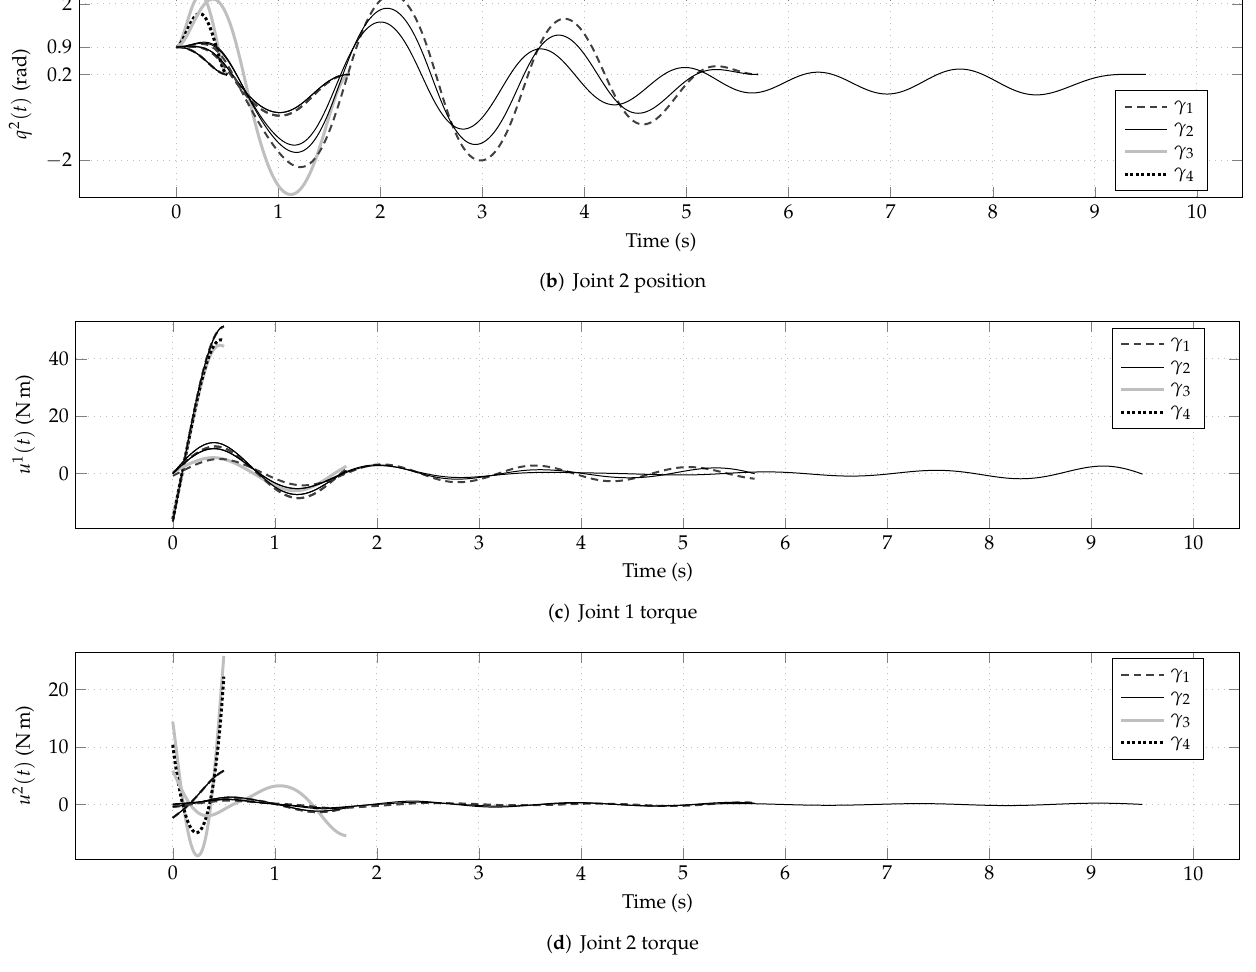
Figure 7. Numerical solution of the optimal control for a downward motion (see Step 1 of Section 6.1.3). Optimal torque and position evolution along four simulated trajectories: T = 0.5s, T = 1.7s, T = 5.7s, and T = 9.5s. Trajectory durations correspond to values of T in Table 1, which are the maximum values at which NDSolve successfully determined a solution. Higher values of T and narrower motions are achieved with the invariants γ 1 and γ 2